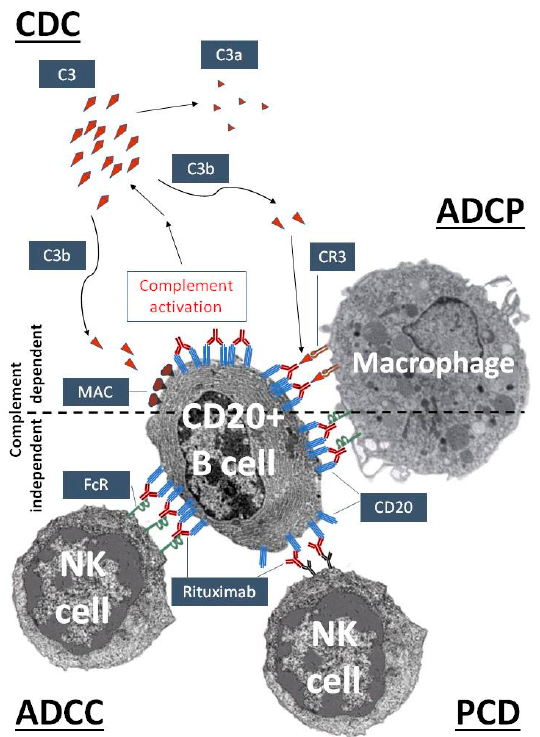
Figure 1. Complement activation as an essential mechanism of the therapeutic action of rituximab, an anti-CD20 antibody. Rituximab recognizes CD20 on the surface of pre- and mature B cells. After binding, the complement activation cascade is initiated by the classical pathway leading to the cleavage of C3 into C3a and C3b. C3b can cause complement-dependent cytotoxicity (CDC) by promoting the assembly of the membrane attack complex (MAC), while complement receptors on phagocytic cells, such as complement receptor type 3 (CR3) on macrophages, can mediate complement-enhanced antibody-dependent cell-mediated phagocytosis (ADCP). Surface-bound rituximab can trigger natural killer (NK) cells and macrophages by complement-independent mechanisms, via antibody-dependent cell-mediated cytotoxicity (ADCC), ADCP and, to a lesser degree, the induction of programmed cell death (PCD).